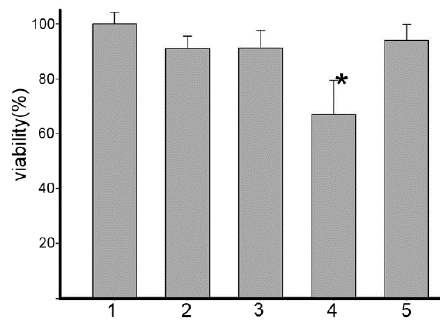
Figure 1. Inhibition of HepG2 cell proliferation by Dp44mT and its copper complex in the absence or presence of HSA. 1, control; 2, Dp44mT; 3, Dp44mT + HSA (1:1); 4, Dp44mT-Cu; and 5, Dp44mT-Cu + HSA (1:1). * p < 0.01 ( t -tests).